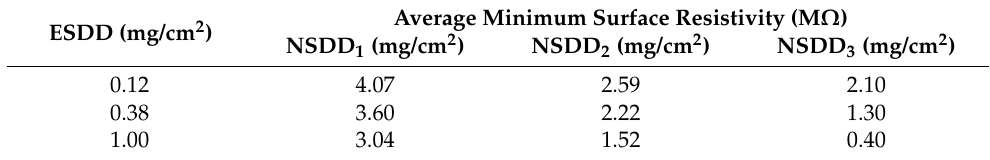
Table 5. Average minimum surface resistivity corresponding to each ESDD for various